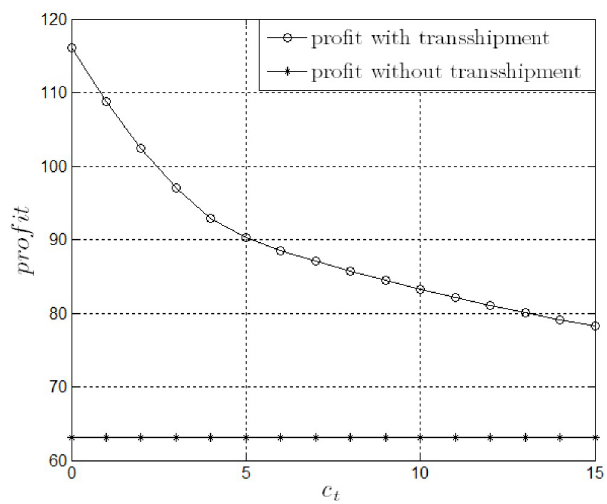
Figure 3. Relation between profit and transshipment cost